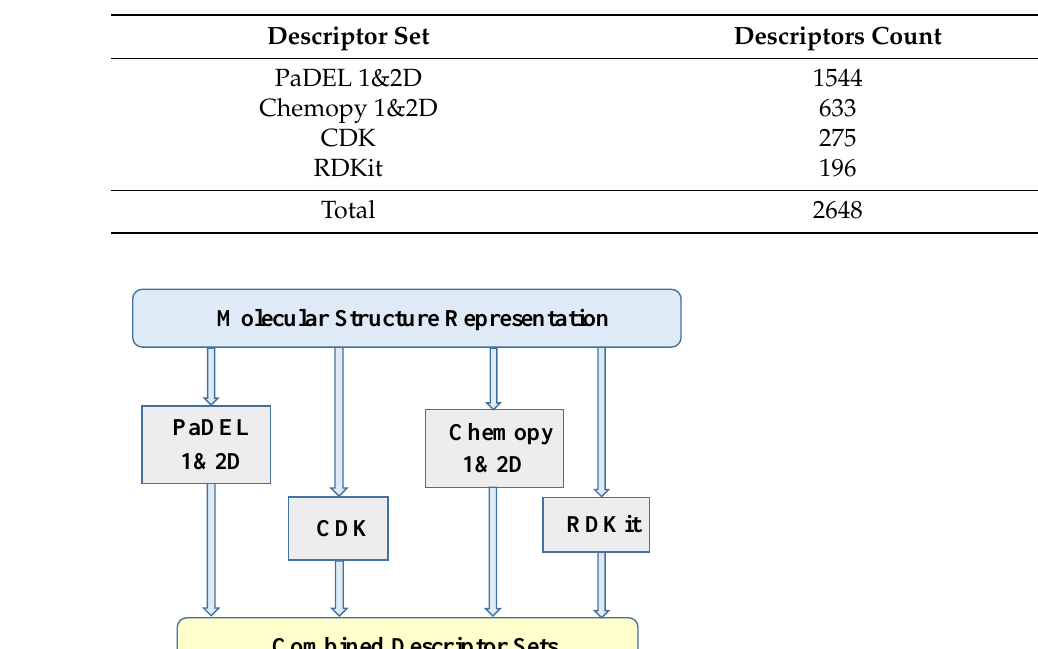
Table 1. Details of the descriptor sets.